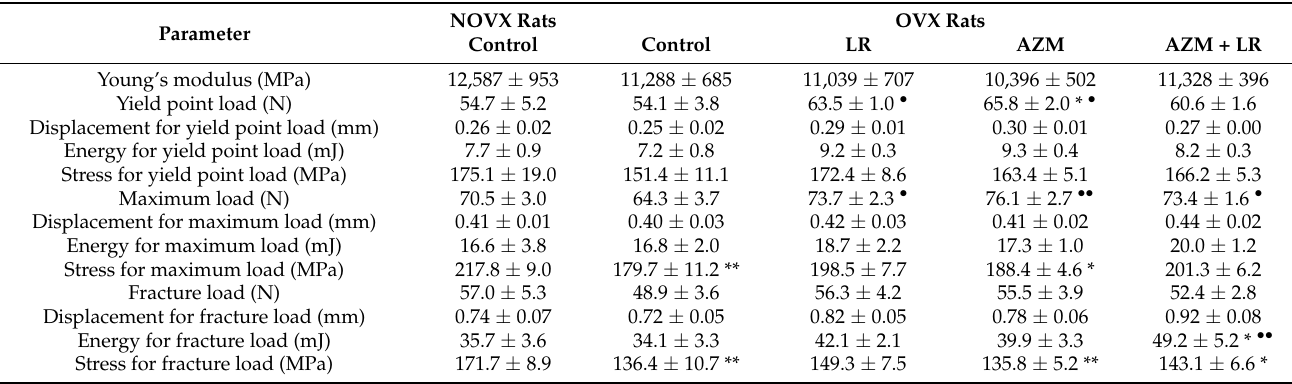
Table 5. Effect of azithromycin (AZM) and/or Lactobacillus rhamnosus (LR) on mechanical properties of the tibial diaphysis in ovariectomized